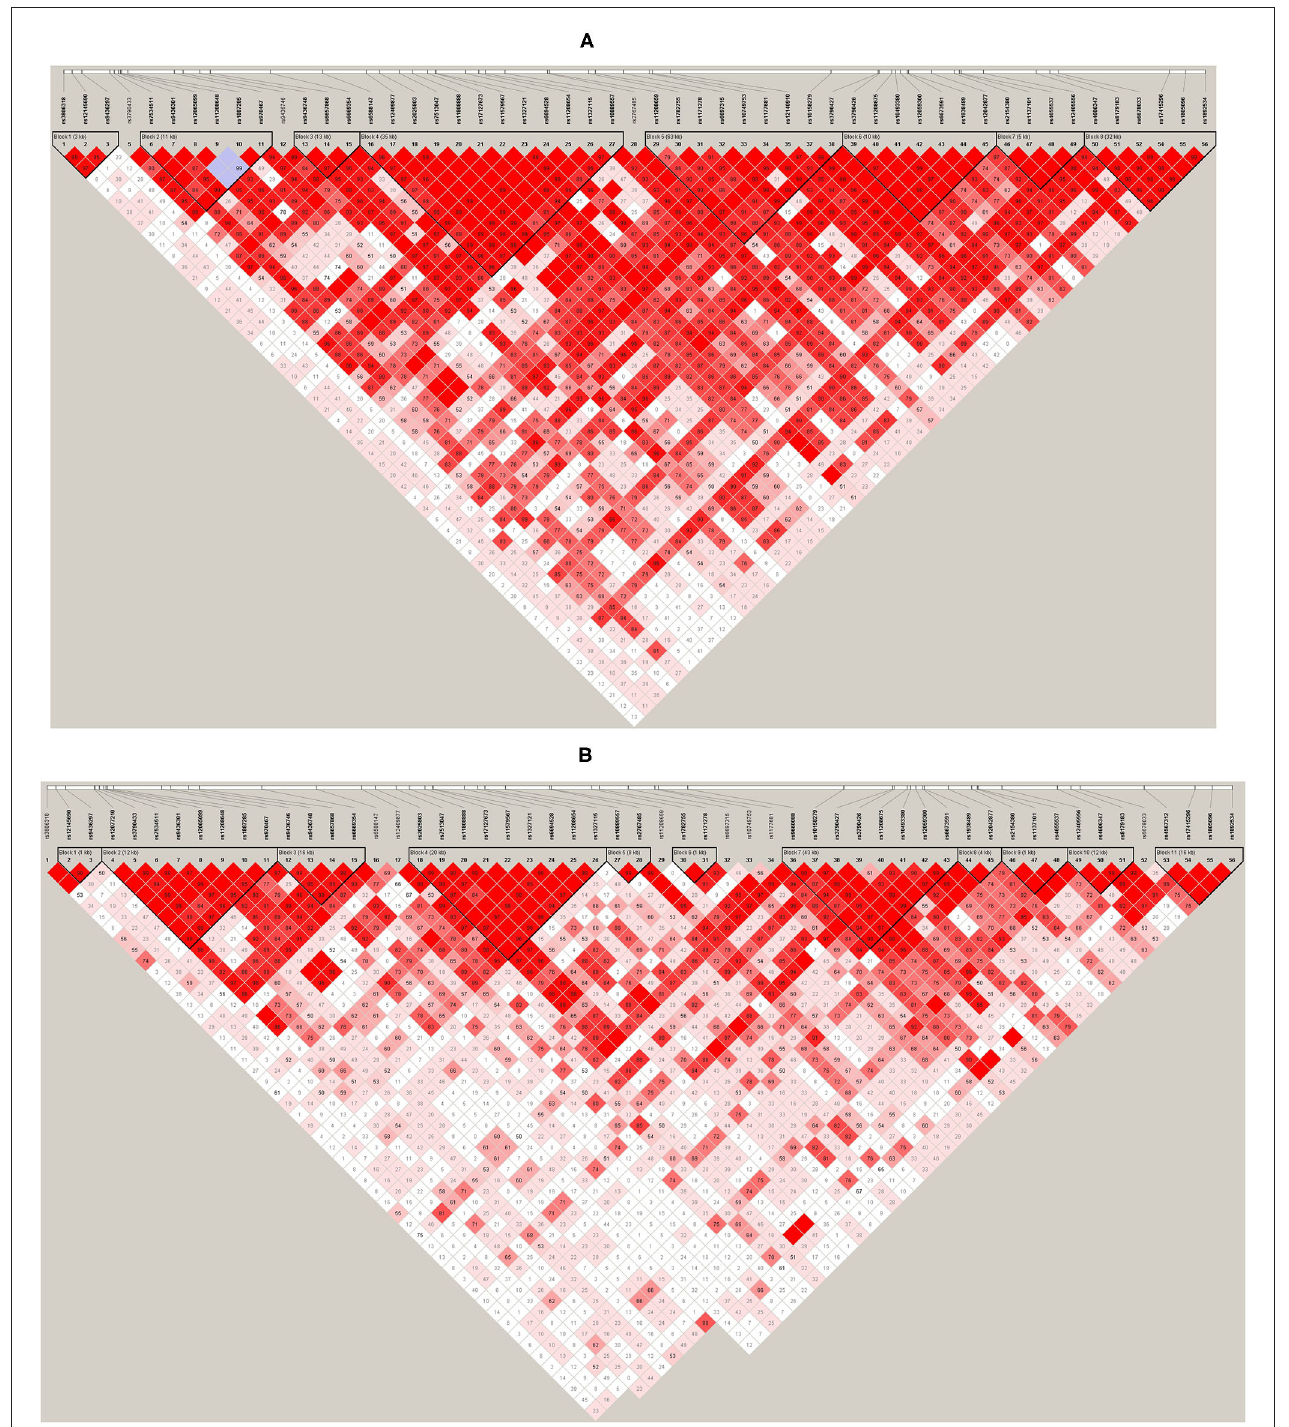
FIGURE 2 | (A) LEPR linkage disequilibrium (LD) plot for the European American group. (B) LEPR LD plot for the African American group. Pairwise LD is represented as red for strong LD, blue for non-significant LD, and white for little or no LD. in post-menopausal women (56–58). Interestingly, a haplotype (AB3H2) in the African American sample contained the minor G allele at rs2060715 and was found to be associated with